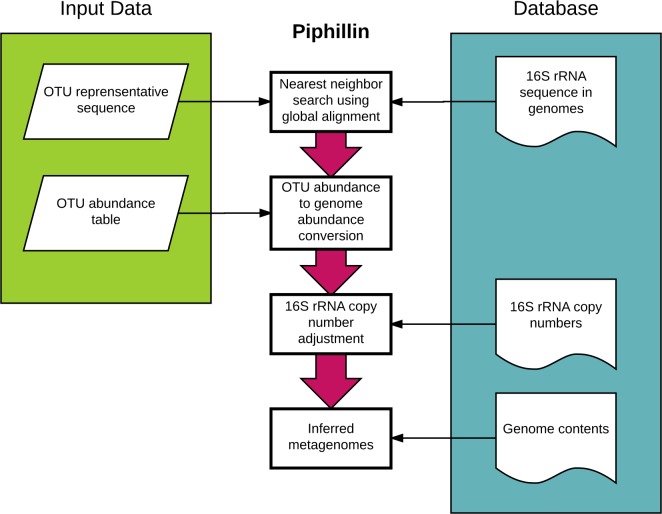
Piphillin algorithm.The representative sequence of each OTU in the sample is first searched against 16S rRNA sequences in the genome database to obtain inferred genome(s). Then the OTU abundance table is converted to a genome abundance table. The resulting table is normalized by the 16S rRNA copy number of each genome and a metagenome is inferred using the gene contents (copy number of each gene) of each genome in the database.